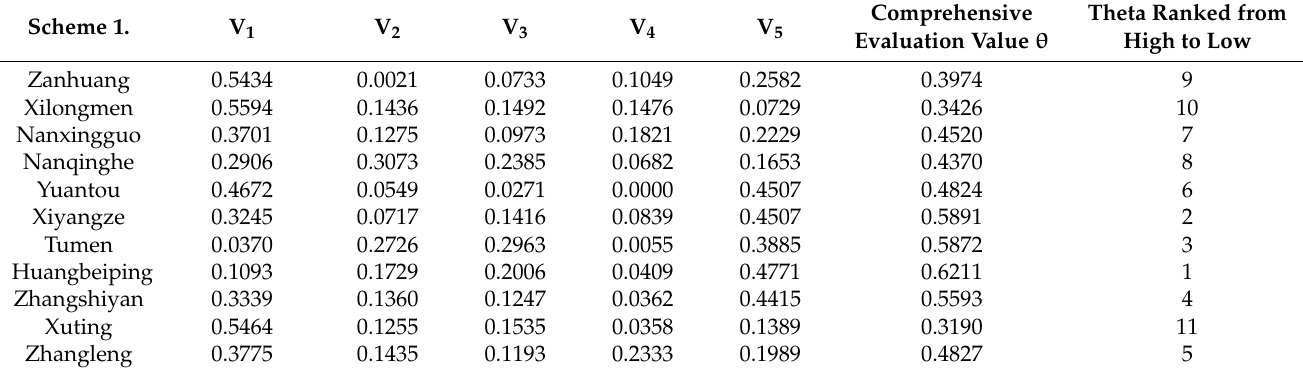
Table 4. Comprehensive evaluation results of water resources carrying capacity by the entropy weight method in Zanhuang County. Scheme 1.